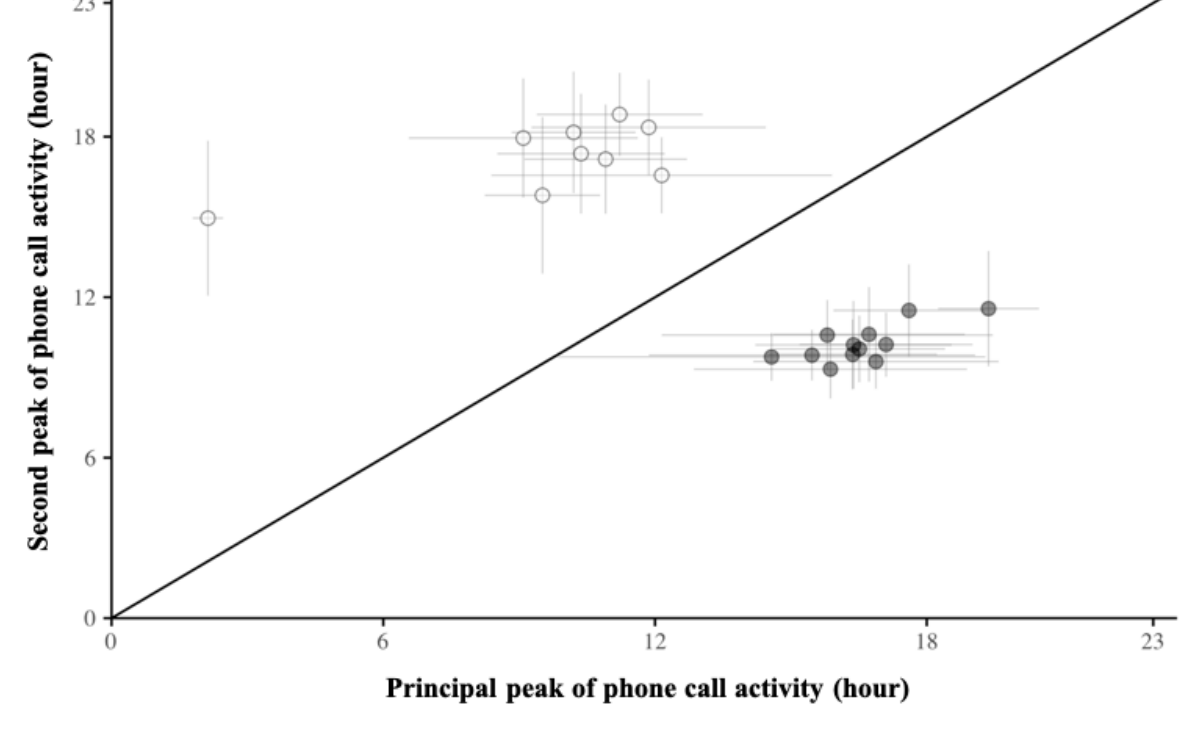
Figure 4. Morningness-eveningness observed in outgoing telephone calls. This figure displays the two broad periods of outgoing telephone call activity. Circles represent peaks of telephone call activity, and each period duration is represented with horizontal and vertical lines. Each circle is colored according to its morningness-eveningness trend given by k-means